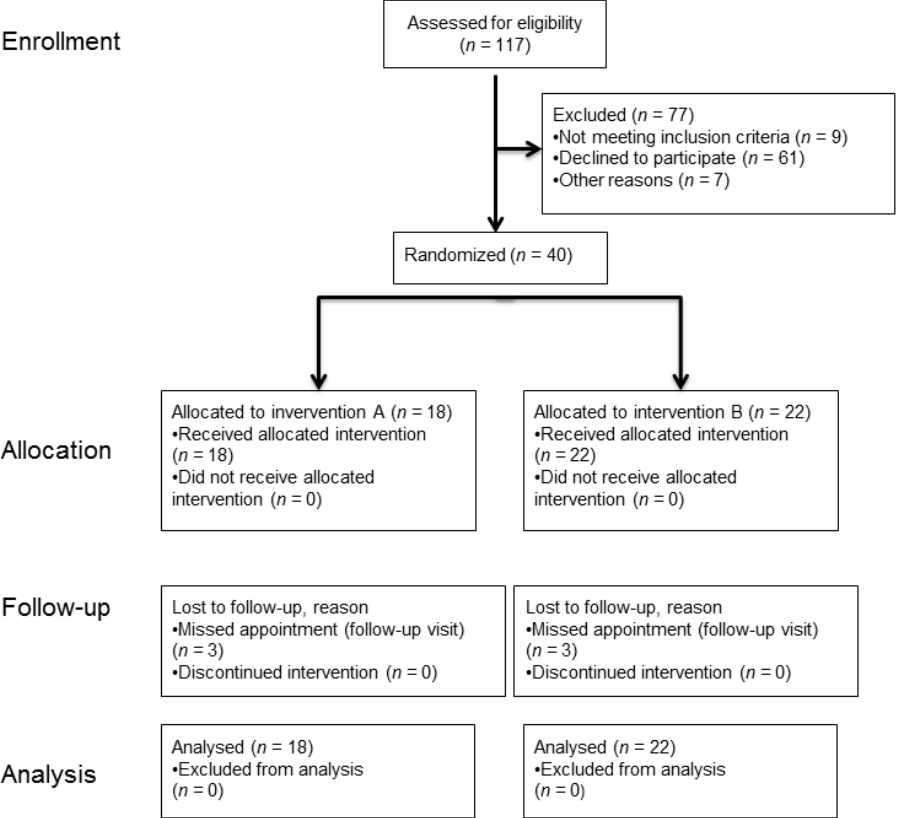
Figure 6. Study flow diagram (according to CONSORT 2010). Intervention A: cord. Intervention B: paste.